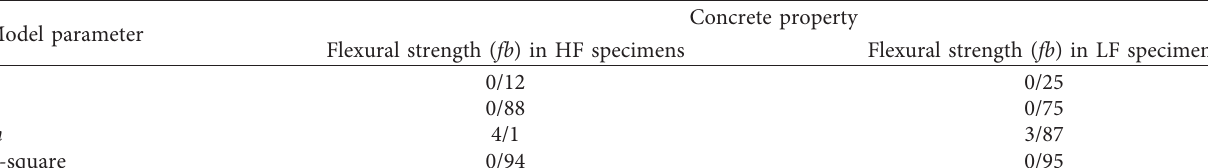
Table 7: Parameter of reduction function for HSRC specimens at 28days.